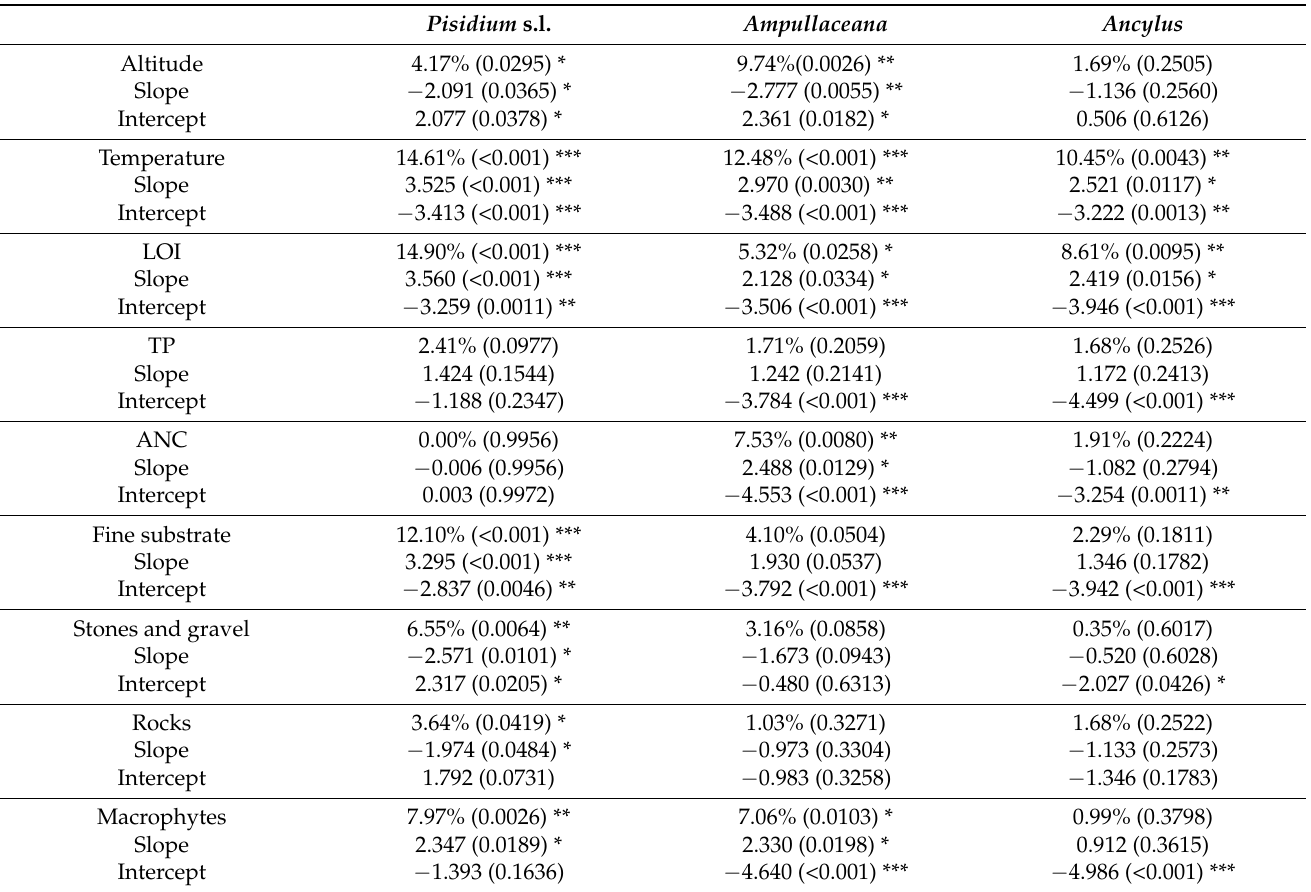
Table A4. Binomial logistic regression models ( z -scores) and associated significance in parenthesis ( p -values), estimating the probability of presence of either Pisidium s.l., Ampullaceana , and Ancylus as a function of the selected environmental variables and altitude. Salmonids are not considered since they can only compute as presence/absence. Percentage values in the first row of each analysis indicate the percentage of deviance accounted for by each model, with significance ( p -values) in parenthesis, following a chi-square test on a deviance table. Asterisks indicate the level of significance: * p < 0.05, ** p < 0.01, *** p <